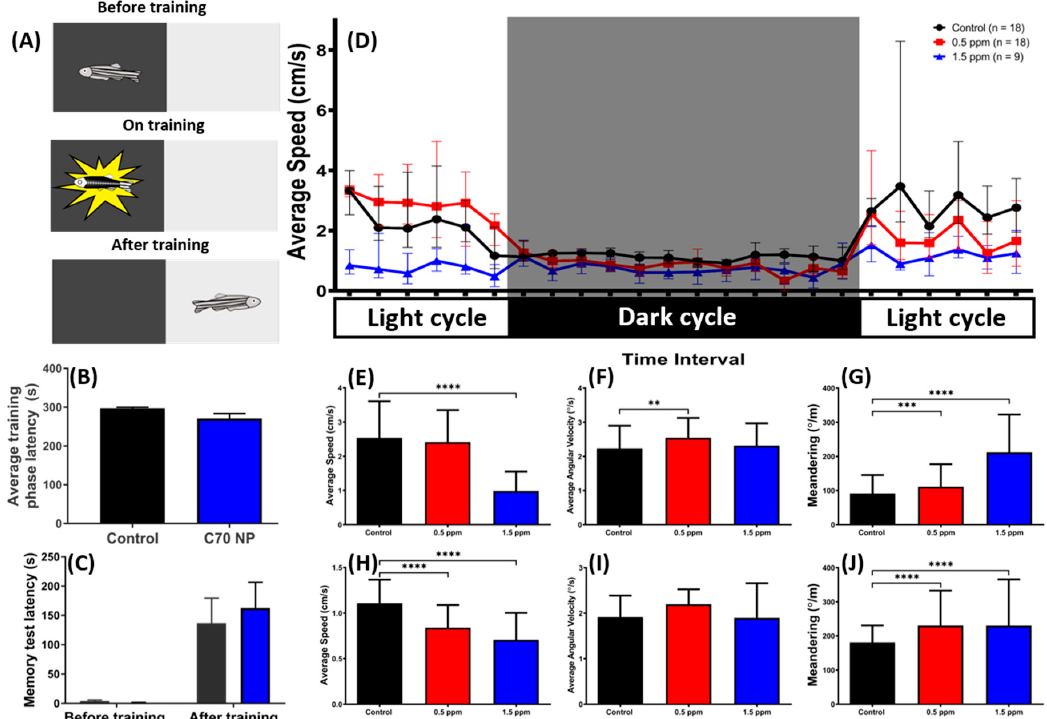
Figure 6. The short-term memory and circadian rhythm assay for the untreated control and C 70 NP-exposed fish after 7- and 21-day exposure, respectively. ( A ) Schematic showing the experimental protocol for the passive avoidance test. ( B ) The average training phase latency on zebrafish learning. ( C ) The memory retention latency for the memory test. The data are expressed as the mean ± SEM and were analyzed by two-way ANOVA with Sidak’s multiple comparisons test as a follow-up test ( n = 10 for the untreated control; n = 6 for the C 70 NP-exposed fish). ( D ) Comparison of time chronological changes of the average speed between wild-type and C 70 NP-exposed fish in the day and night cycle. The grey area shows the dark period and the unshaded area is the light period. Comparison of ( E ) average speed, ( F ) average angular velocity, and ( G ) meandering at light period. Comparison of ( H ) average speed, ( I ) average angular velocity and ( J ) meandering at the dark period. The data are expressed as the median with interquartile range and were analyzed by Kruskal–Wallis test, with Dunn’s multiple comparisons test as a follow-up test ( n = 18 for the untreated control; n = 18 for 0.5 ppm C 70 NP-exposed fish; n = 9 for the 1.5 ppm C 70 NP-exposed fish; *** p < 0.001, **** p < 0.0001).